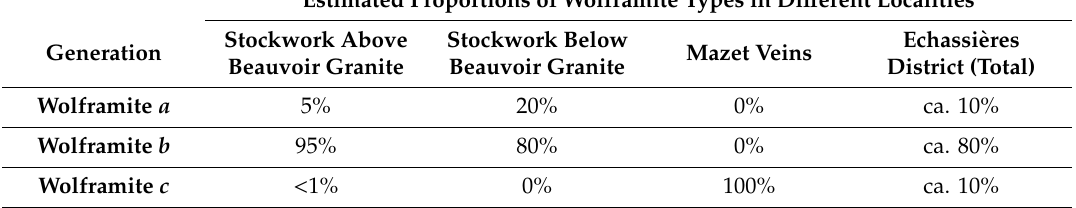
Table 3. Rough estimation of the di ff erent proportions of wolframite types as a function of their location in the Echassi è res